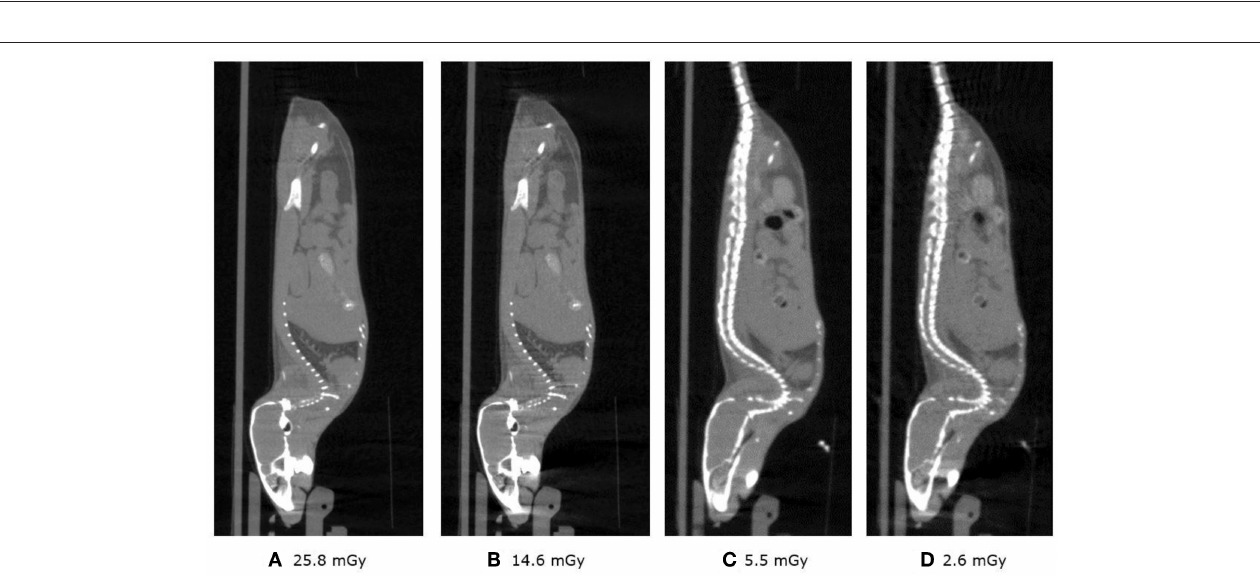
FIGURE 12 | (A–D) Above show the 4 sagittal views with current and acquisition time settings such that approximately the dose is halved starting at 25.8 and finishing at 2.6 mGy.